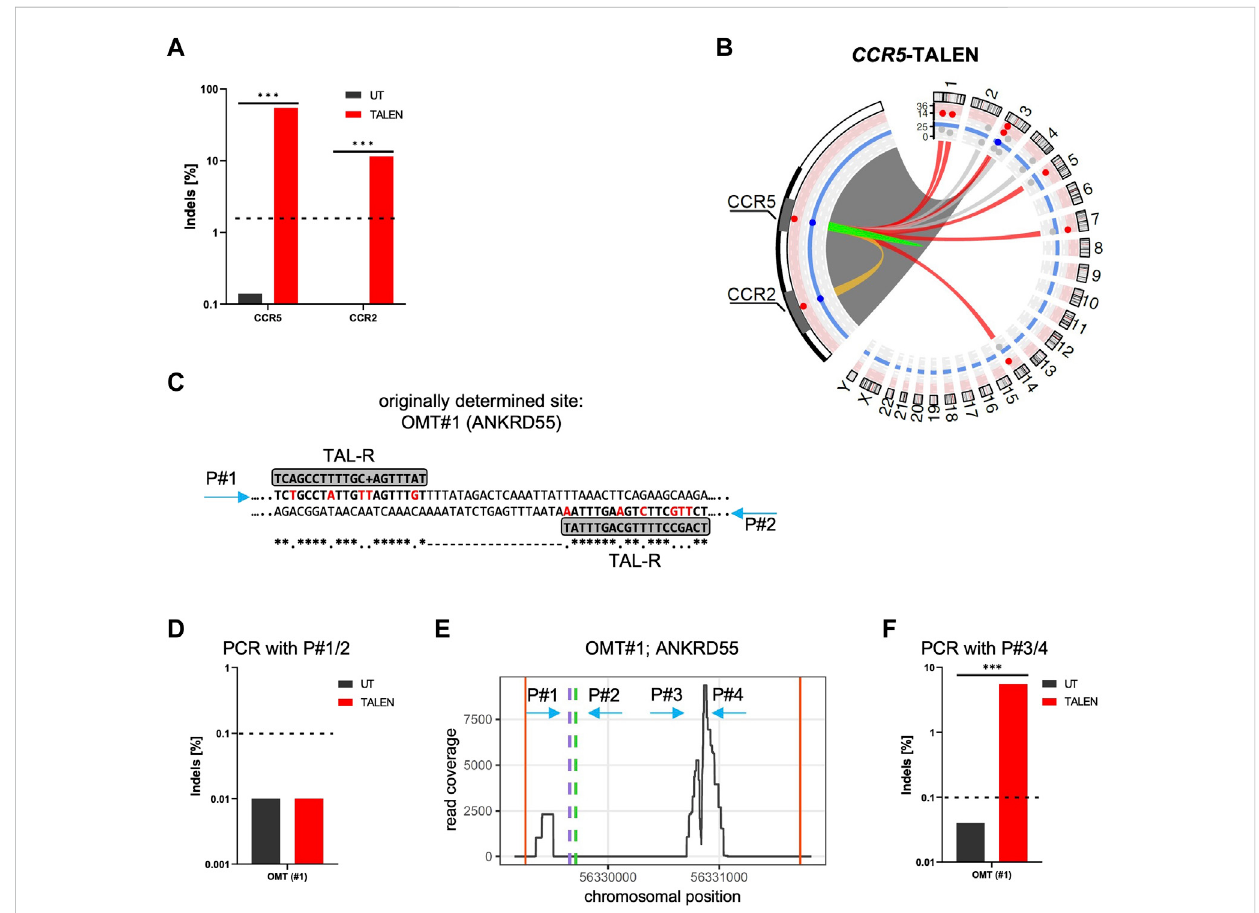
FIGURE 1 CAST-Seqanalysisfor CCR5 -targetingTALEN. (A) NGS-basedgenotypingof CCR5 and CCR2 .IndicatedisthefractionofallelesbearingIndelsatthe CCR5 on-target siteand theoff-target sitein CCR2 inuntreated (UT) Tcells, and Tcells edited with TALEN. (B) Structural variations.Circos plot illustrates CAST-Seqresultswithenlargementofthechromosomethreeregionencompassing CCR5 and CCR2 loci.Linesrepresentchromosomalrearrangements with the CCR5 target site: OMTs with > 20 hits in red, NBSs with > 40 hits in grey, ambiguous classi fi cation (OMT/HMT) in yellow. Red and blue layers represent the alignment and homology scores, respectively. (C) Alignment. Illustrated is the CAST-Seq alignment for ANKRD55 (OMT#1) to two right TALEN arms. Mismatched bases are highlighted in red. Positions of primers P#1/P#2 for NGS validation are indicated. (D) Genotyping of ANKRD55 . NGS wasperformedwithprimersP#1/P#2. (E) Coverageplotof ANKRD55 .Plotshowschromosomalpositionvs.numberofreads,theputativeTALENbinding sites (green and purple dashed lines), as well as the positions of primers P#1/P#2 and P#3/P#4. Red vertical lines show boundary of region. (F) Genotyping of OMT#1. NGS was performed with primers P#3/P#4. *** speci fi es p -value < 0.001 (Fisher ’ s exact test, Bonferroni corrected p